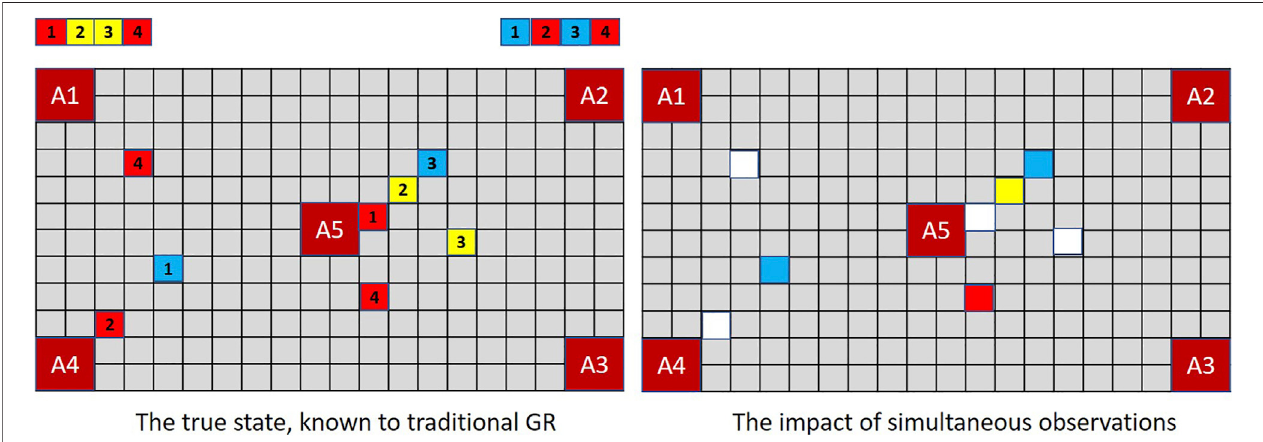
FIGURE 4 | When multiple events occur simultaneously with full observability, a traditional GR system is capable of recording them all; but a human — or a GR system that supports the notion of selective attention — records only one. Thus, given shuttles delivering the combination of tokens depicted above, a traditional GR system (left) assesses ( A 1, A 4) and ( A 2, A 5) as equally probable (cost difference (cid:1) − 1) while an extended GR system, if selecting one of two observations randomly at each time-step, may have noticed nothing of signi fi cance so continues to rank all goals equally (cost difference (cid:1)